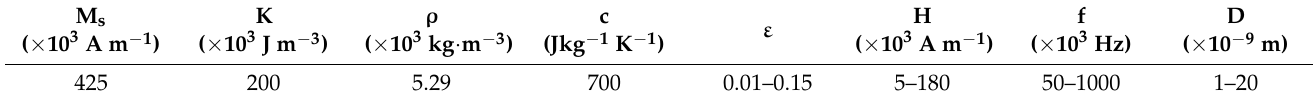
Table 1. Characteristic observables of the CoFe 2 O 4 ferrite nanoparticles and parameters of magnetic field. M s ( × 10 3 A m − 1